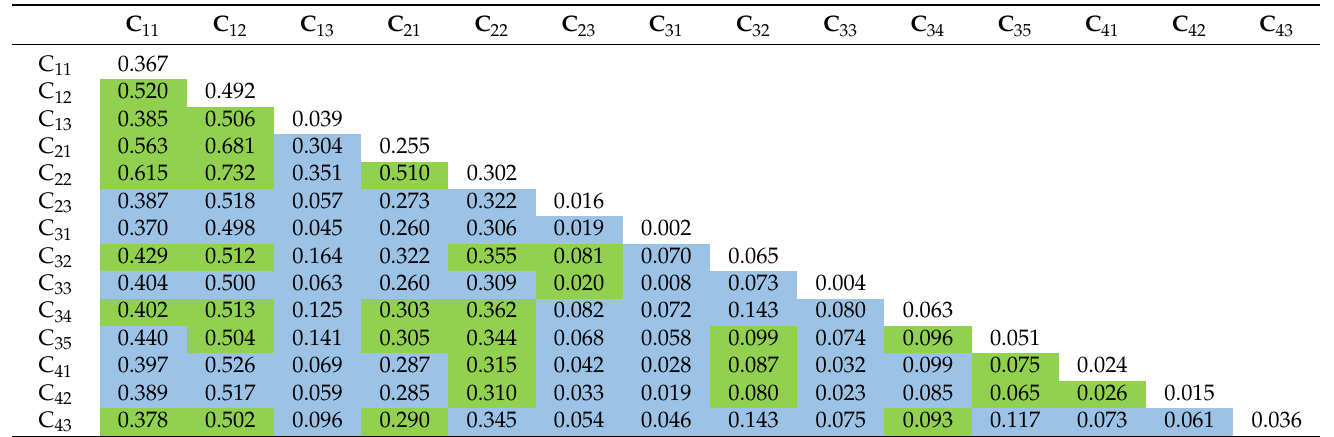
Table 10. Interaction of each paired factor on tea cultivation